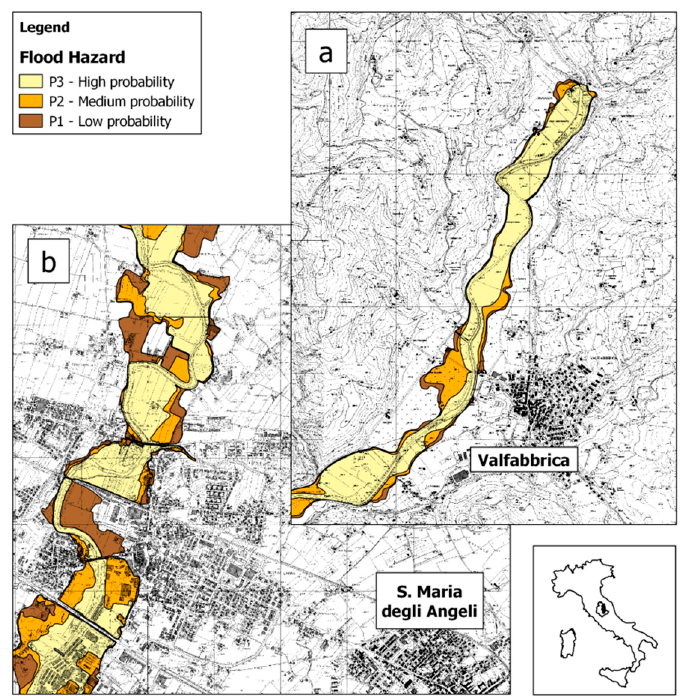
Figure 1. Localization of the case study area in central Italy. Flood Risk Management Plan: hazard map (high, medium and low probability) for areas surrounding the two towns of Valfabbrica ( a ) and Assisi ( b ).